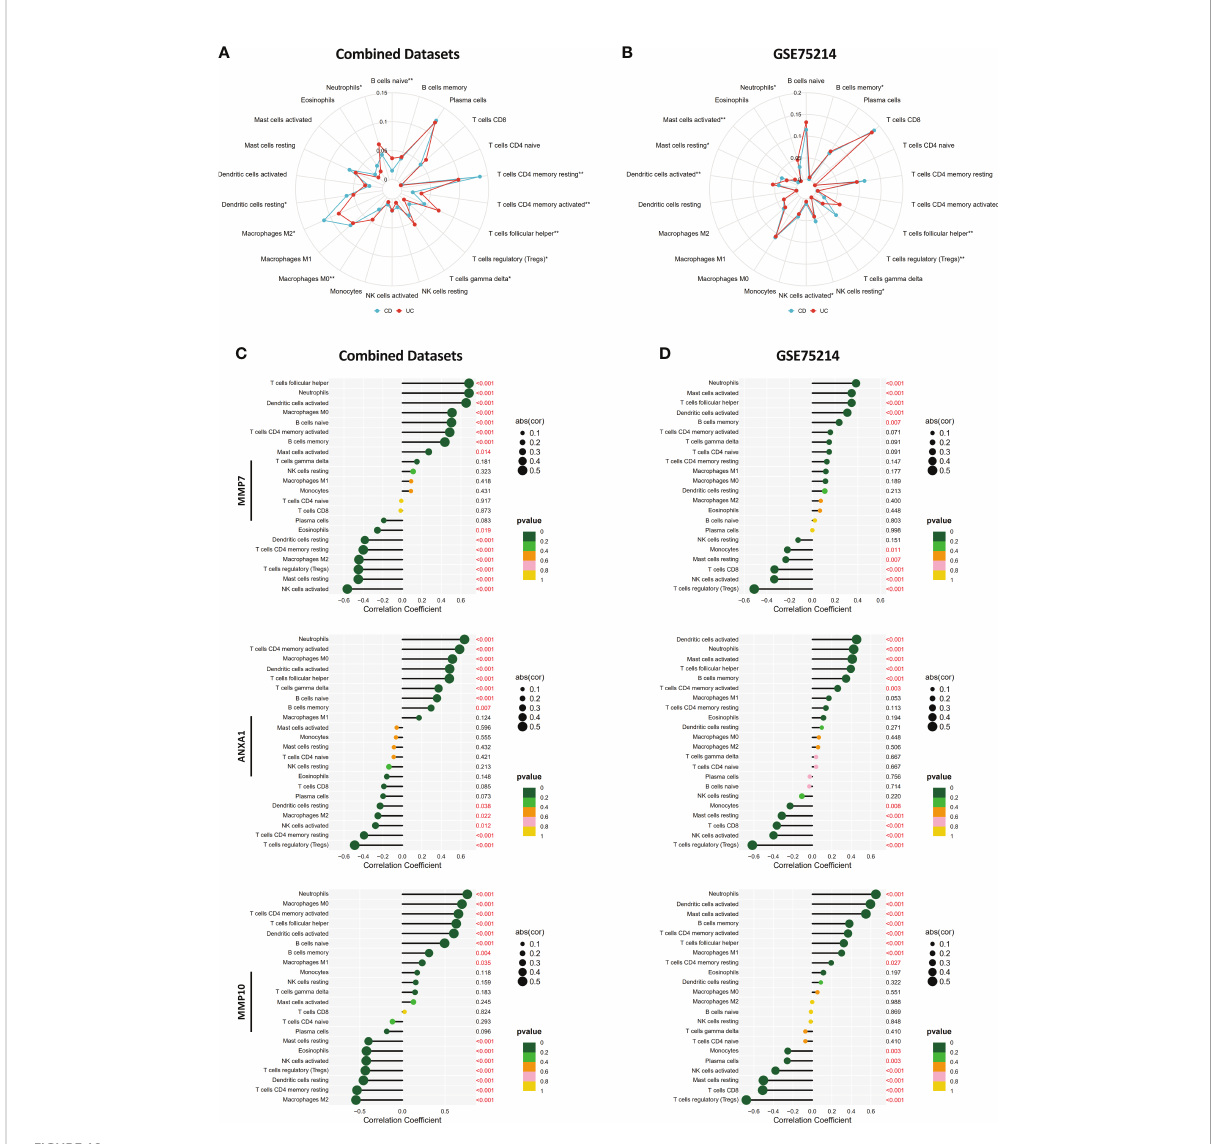
FIGURE 10 Correlations between MMP-associated gene levels and the levels of in fi ltrating immune cells determined by CIBERSORT. Differences in the levels of in fi ltrating immune cells between the CD and UC groups in the Combined Datasets (A) and the GSE75214 dataset (B) . Correlations between the MMP-associated gene levels and immune cell levels were further examined by a Spearman correlation analysis in the Combined Datasets (C) and the GSE75214 dataset (D) , and results with signi fi cant differences are shown (*p < 0.05, **p < 0.01). The results, including data regarding other MMP-associated genes, including CXCL13, MMP3, MMP1 and CXCL1, are illustrated in Supplementary Figure